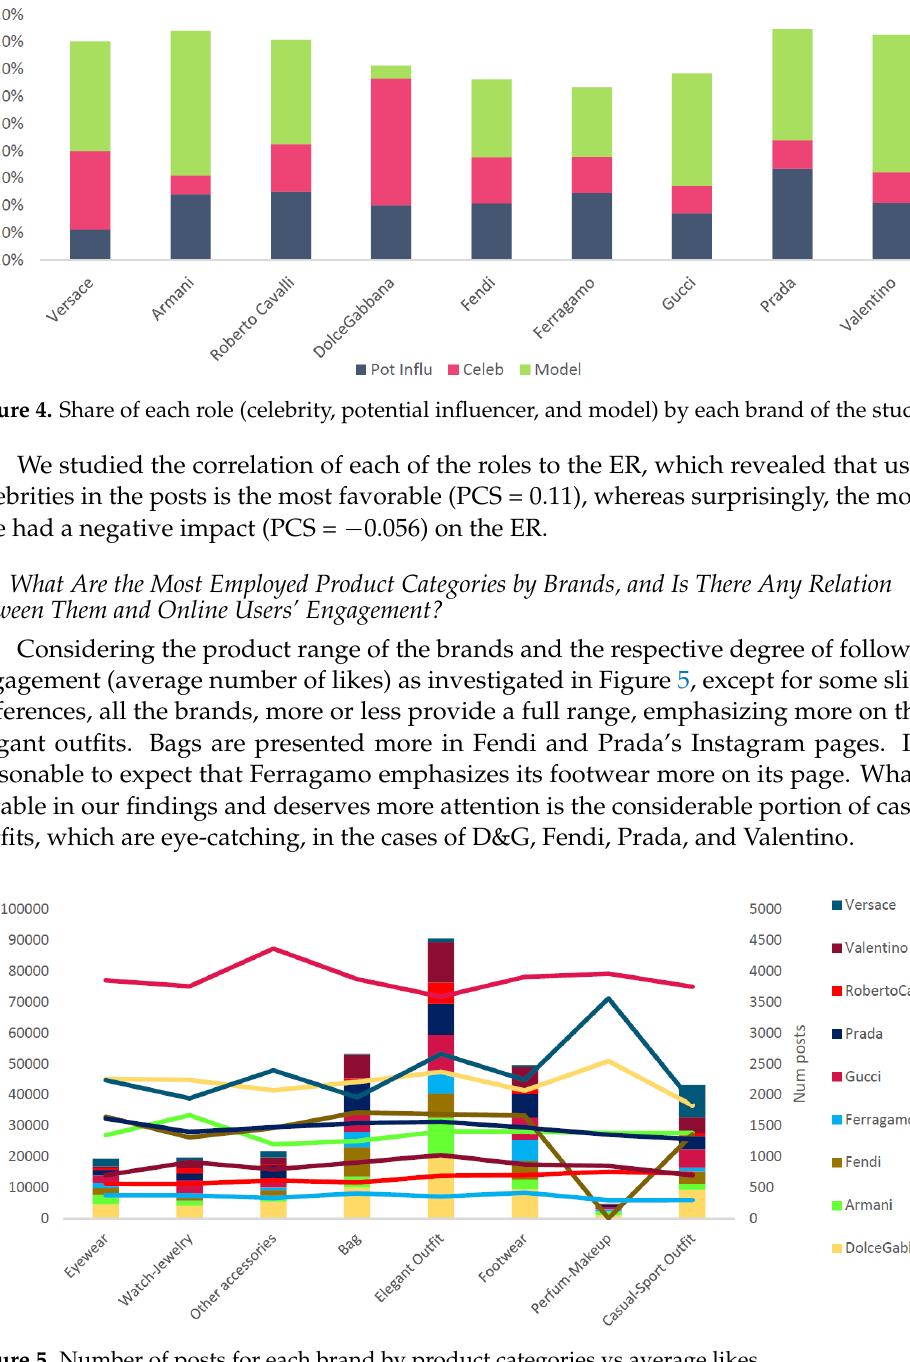
Figure 5. Number of posts for each brand by product categories vs average